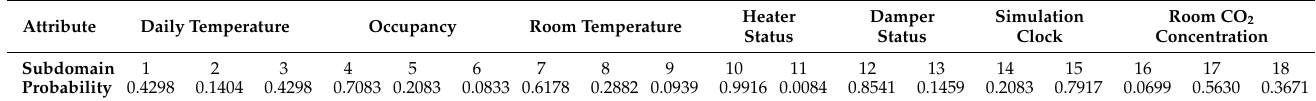
Table 16. Use-Case Subdomain Probability Vector (SPV) for CO 2 Sensor